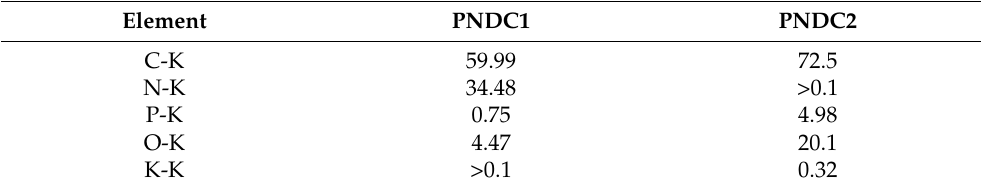
Figure 2. SEM images of PNDC1 ( a , b ) and PNDC2 ( c , d ). The left two images are of magnifications of the carbonized materials at 1000 × magnification. The right two images illustrate 10,000 × magnification. Table 2. EDS shows bulk elemental composition of both phosphorus and nitrogen co-doped materi- als (At%).